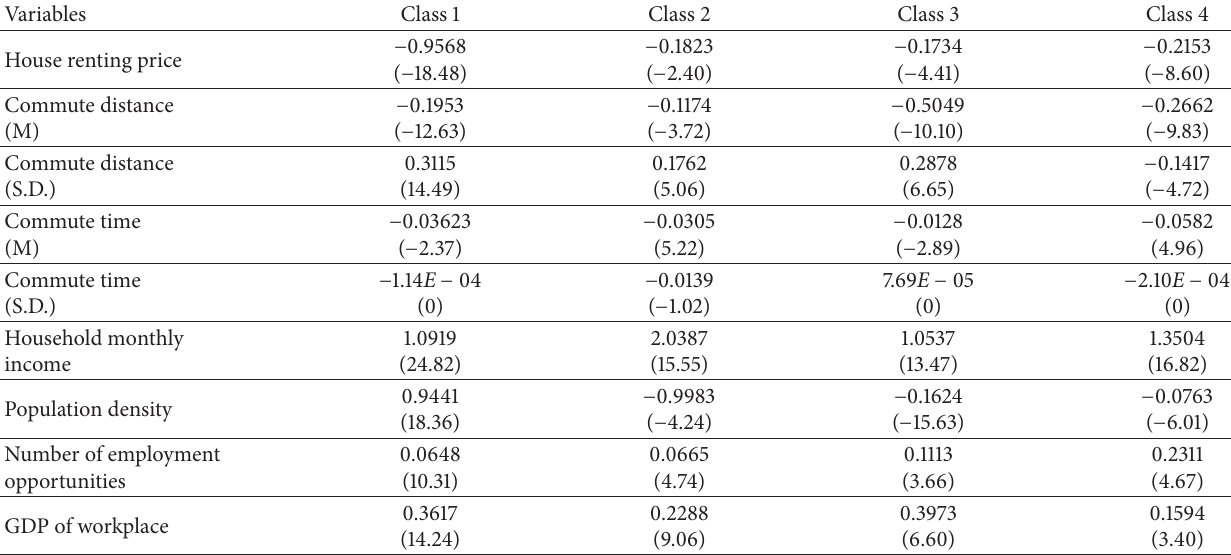
Table 5: Estimation results of four latent